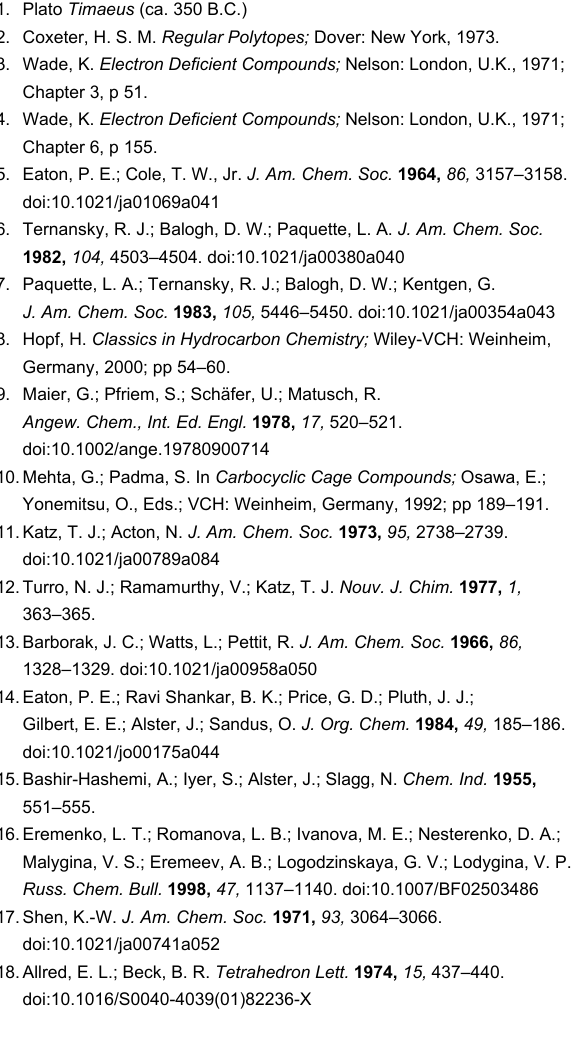
As noted above, molecular analogues of several members of both sets of the complementary polyhedra exhibited by the closo -boranes and by the polycycloalkanes have been constructed from other elemental species: Clusters containing lithium, transition metals, silicon, phosphorus, arsenic, bismuth, lead, etc. have been characterized [61-64], and their architec- tures continue to delight us. The existence of molecules of such exquisite symmetry would surely have fascinated